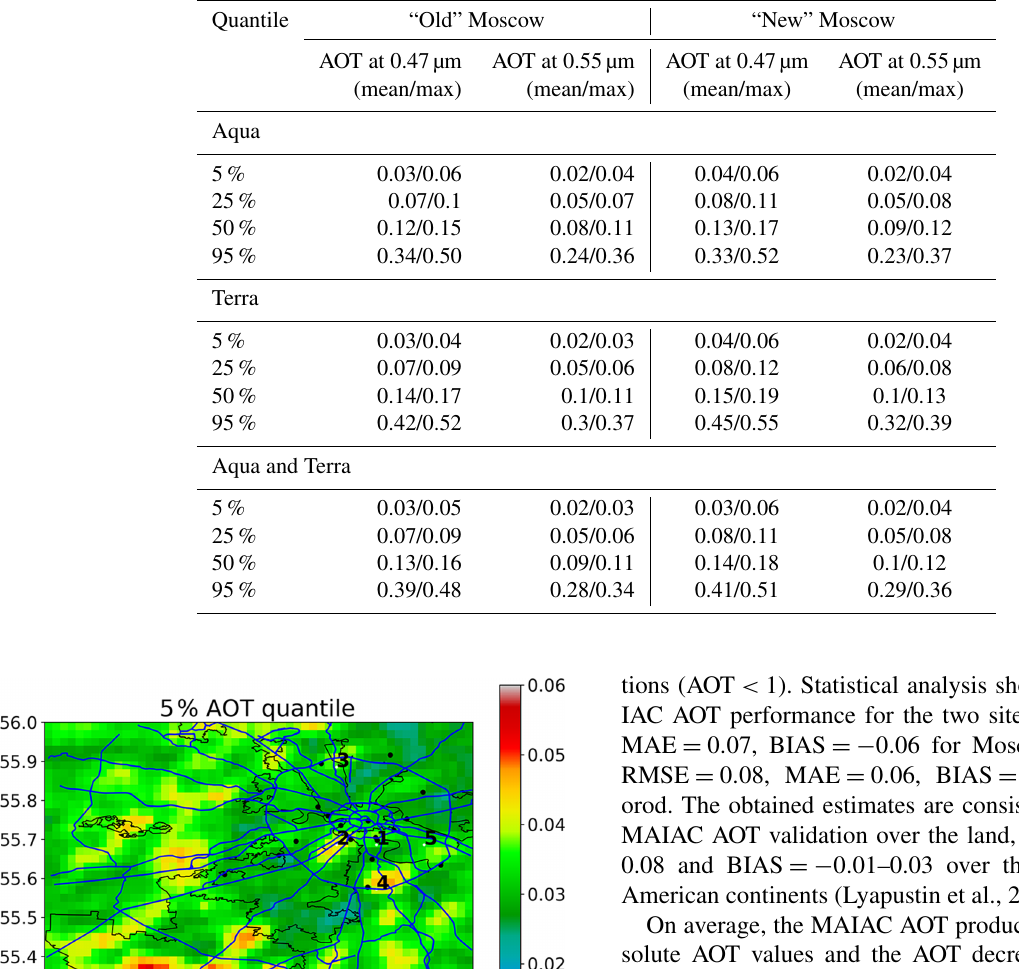
Table 2. Mean and maximum of AOT quantiles (5%, 25%, 50%, 95%) over the “Old” Moscow and “New” Moscow territories, 2001–2017.